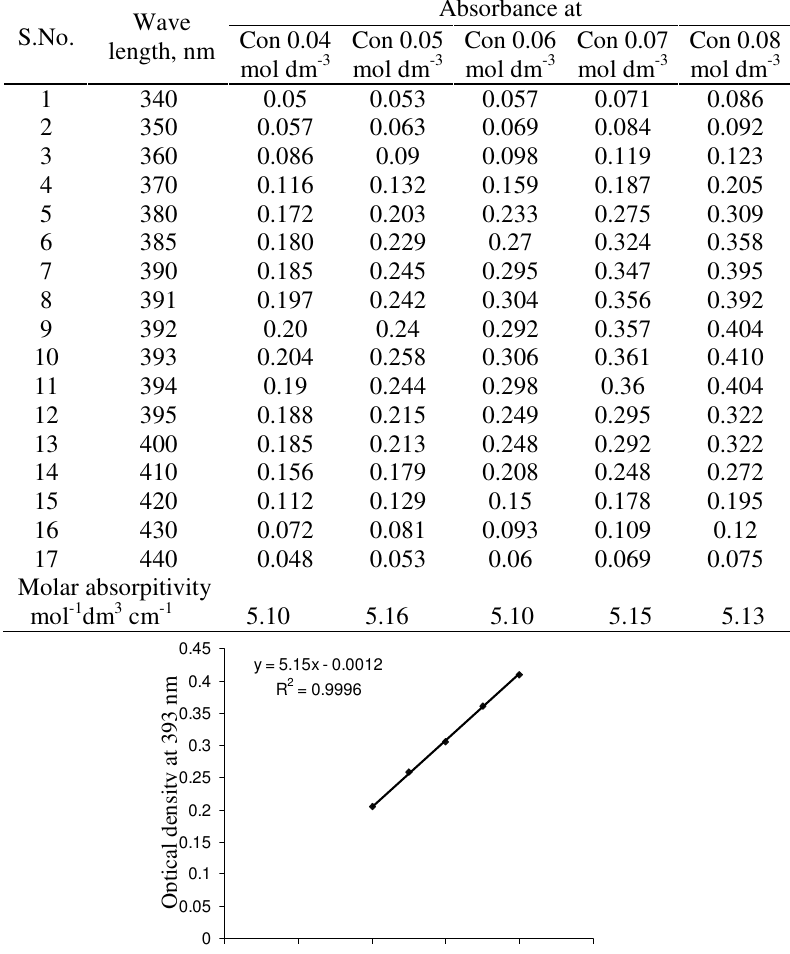
Table 1. Optical densities of Ni(II) ions at different concentrations with change in wavelength.